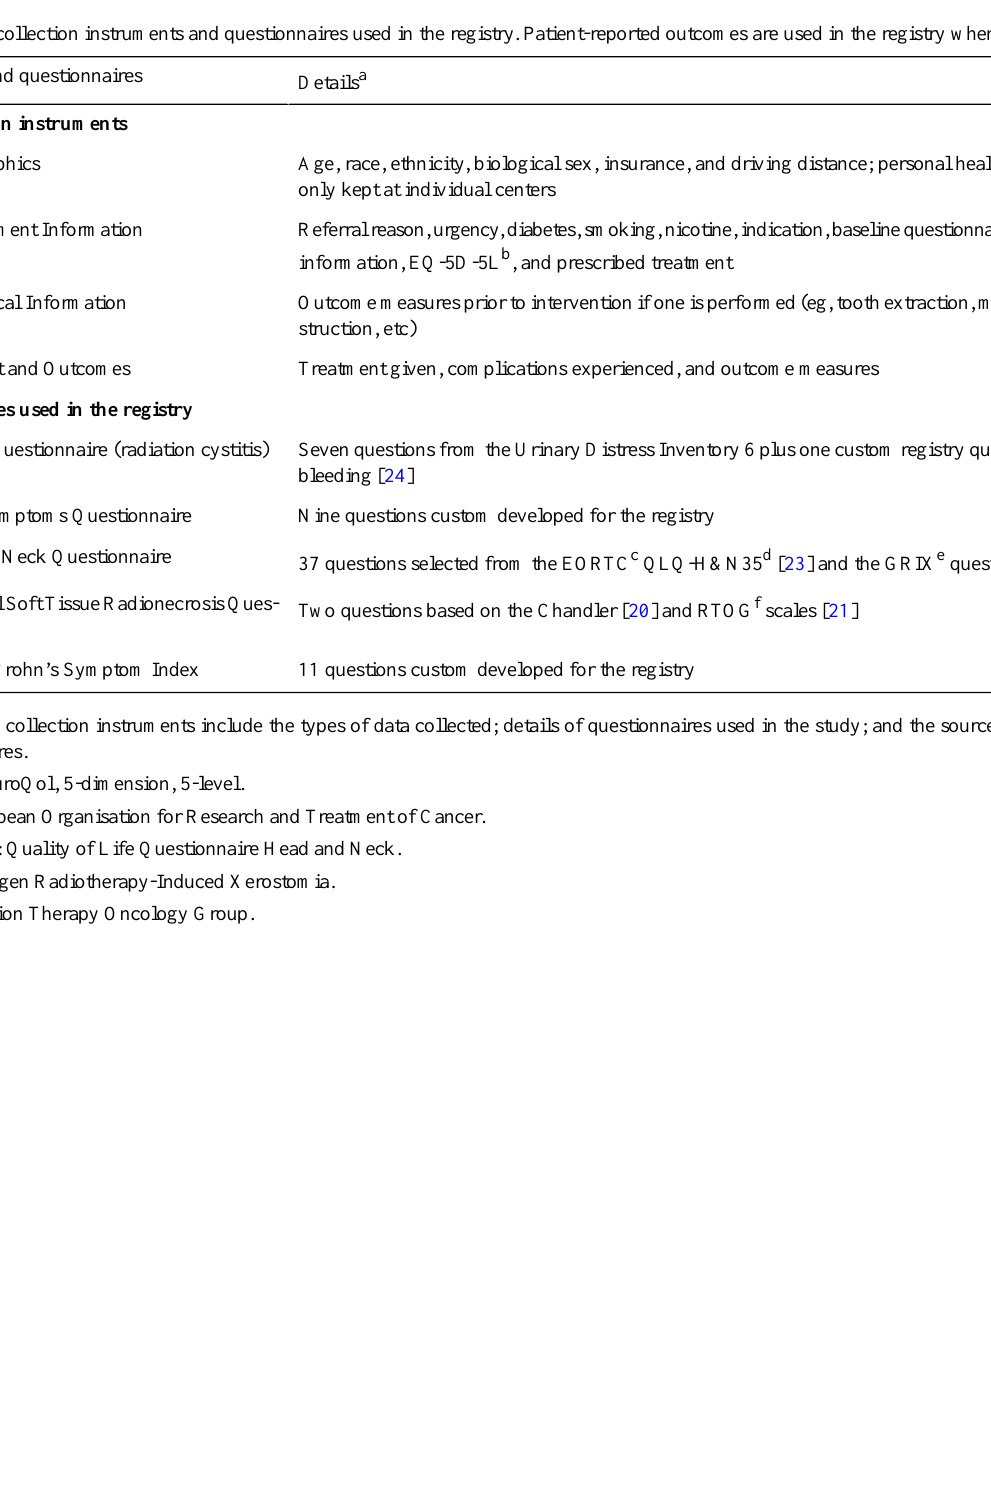
Table 2. Data collection instruments and questionnaires used in the registry. Patient-reported outcomes are used in the registry whenever possible.